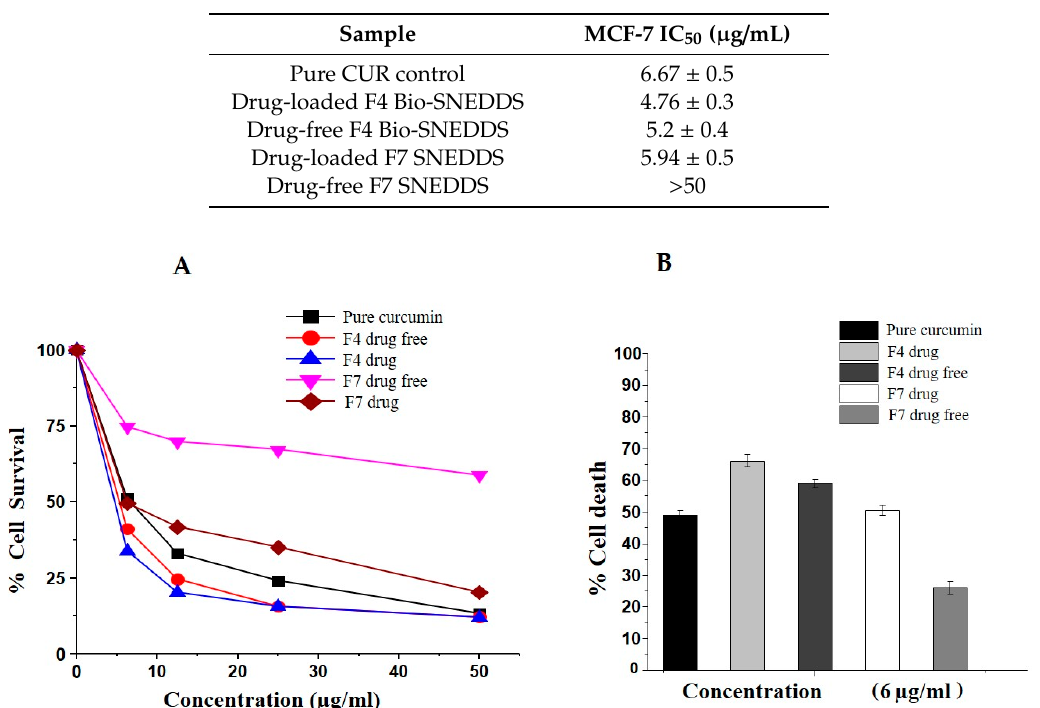
Table 5. The e ff ect of the MTT assay on the formulations to evaluate IC 50 (the concentration that kills 50% of cells).